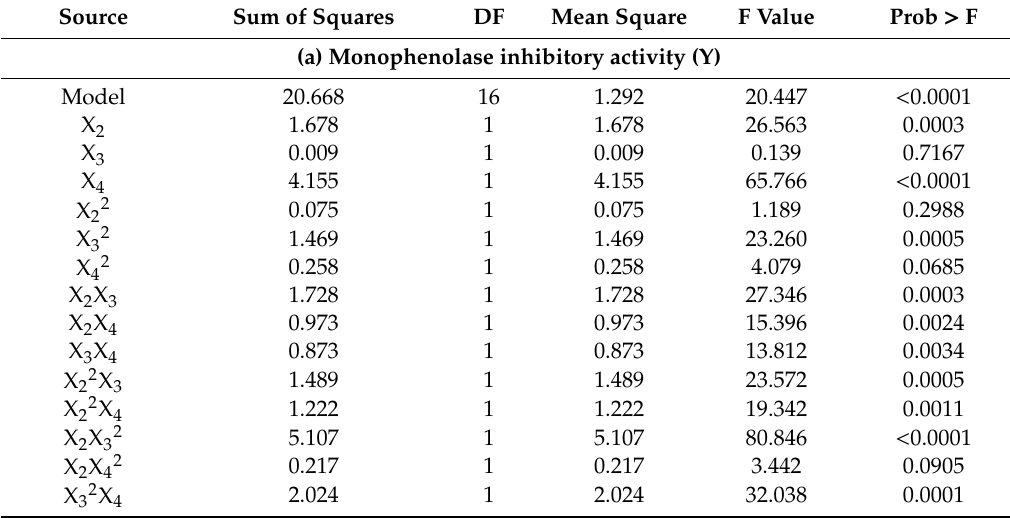
Table 3. ANOVA for crossed reduced quadratic × cubic model: estimated regression model of the relationship between the mixture component (X 1 , X 2 ), process variables (X 3 , X 4 ) and the